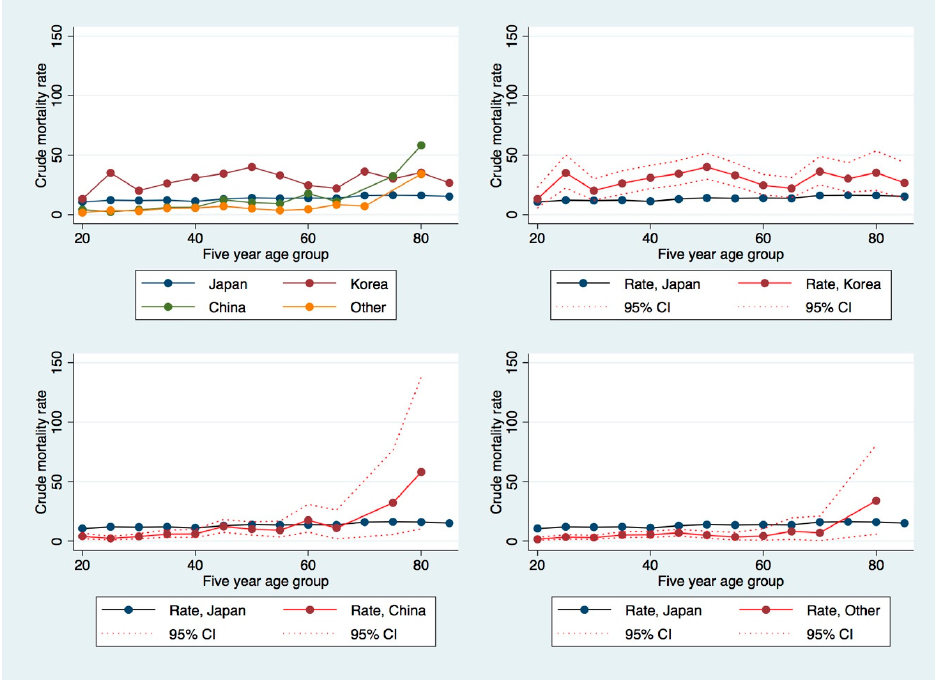
Figure 1. Age-specific crude suicide mortality rates by nationality for women. Clockwise from top left: age-specific rates for Japan, China, Korea, and all other countries; age-specific rates for Korea, all other nations, and China, respectively, with 95% confidence interval and Japanese mortality rates in blue as reference. Int. J. Environ. Res. Public Health 2019 , 16 , x 5 of 9